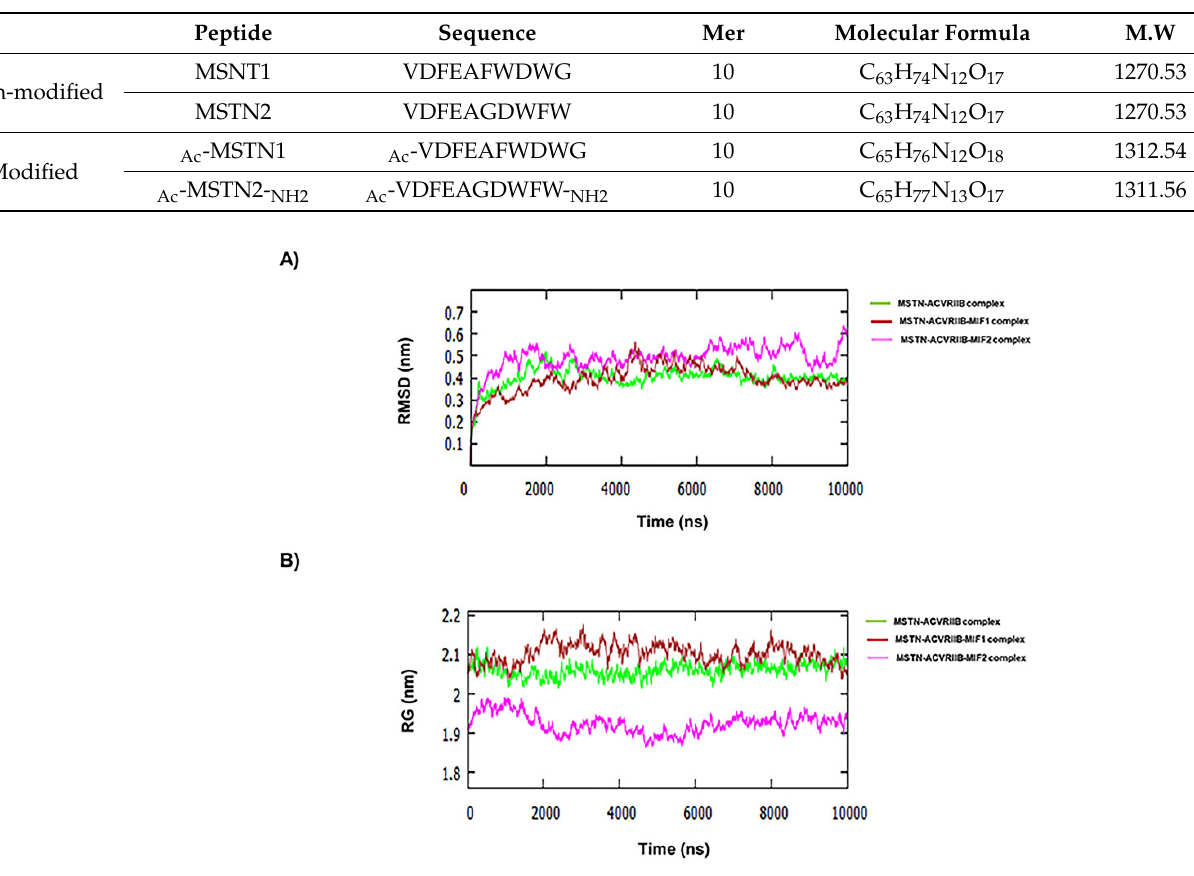
Figure 2. RMSD analysis. ( A ) RMSDs from starting structures for the 10 ns simulations of MSTN– ACVRIIB complex (green), ACVRIIB–MSTN–MIF1 complex (brown), and ACVRIIB–MSTN–MIF2 complex (magenta). ( B ) Changes in radius of gyration (RG) from starting structures for the 10 ns simulations of MSTN–ACVRIIB complex (green), ACVRIIB–MSTN–MIF1 complex (brown), and ACVRIIB–MSTN–MIF2 complex (magenta).